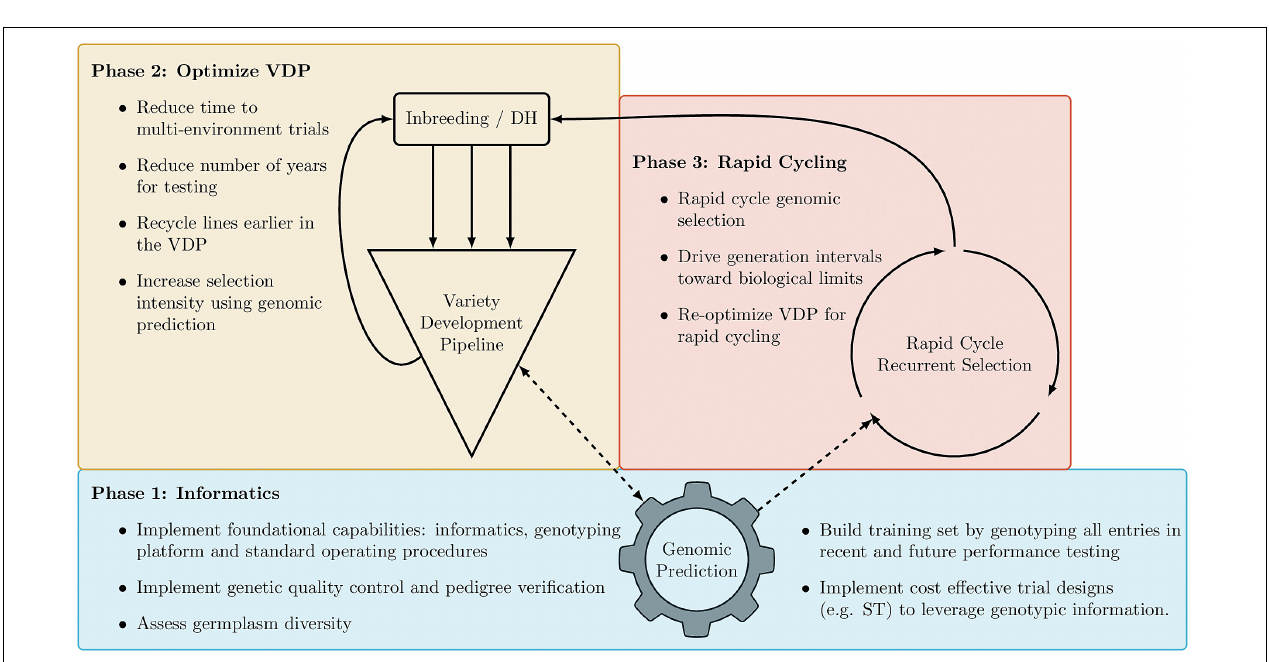
FIGURE 4 | Prediction accuracies for sparse testing (ST) vs. (A) dedicated training set (DTS) prediction accuracies in chickpea lines across six traits and two water regimes, and (B) Full-sib prediction accuracies (FSTS) in maize across three traits and three environments.